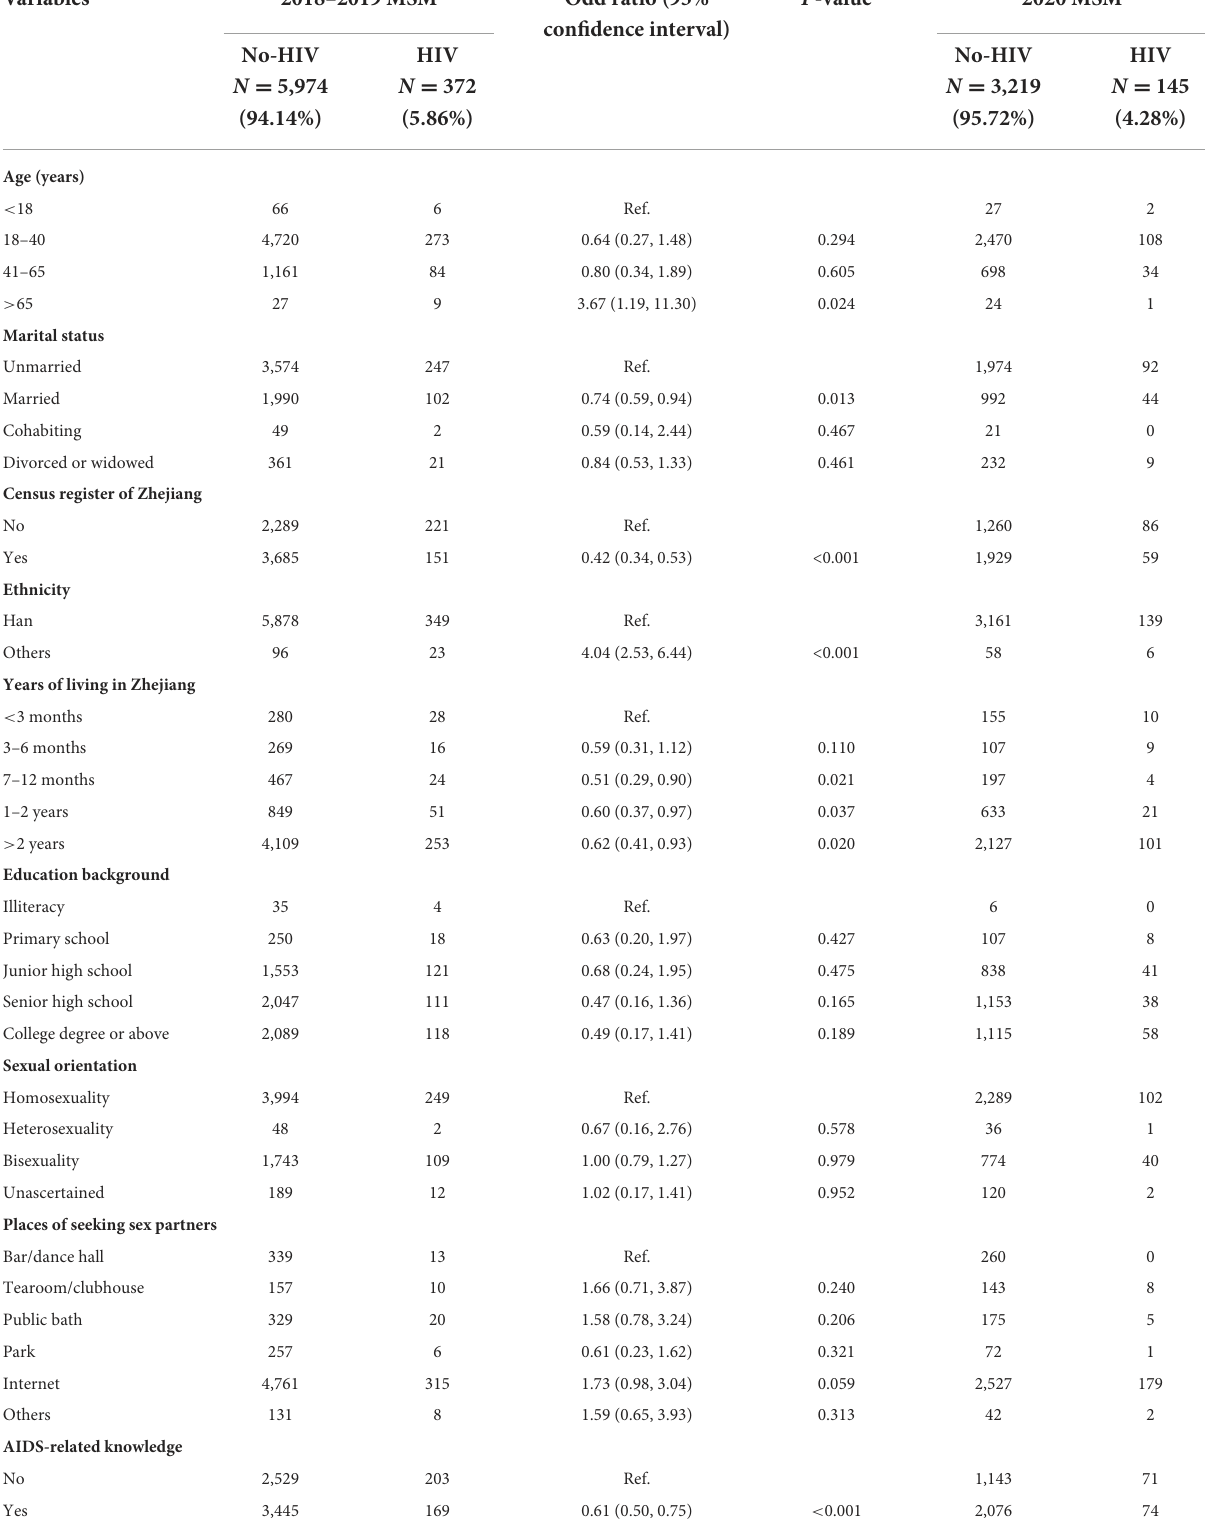
TABLE 2 Basic characteristics of variables in both 2018–2019 and 2020 MSM and univariate associations of potential predictors with HIV infection in 2018–2019